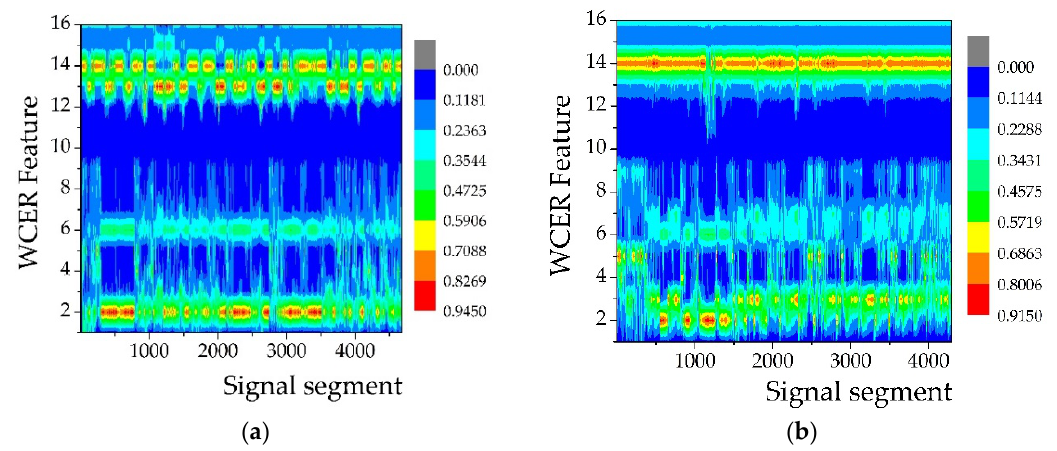
Figure 6. Acoustic–seismic mixed features of different vehicles: ( a ) AAV3; ( b ) DW3.